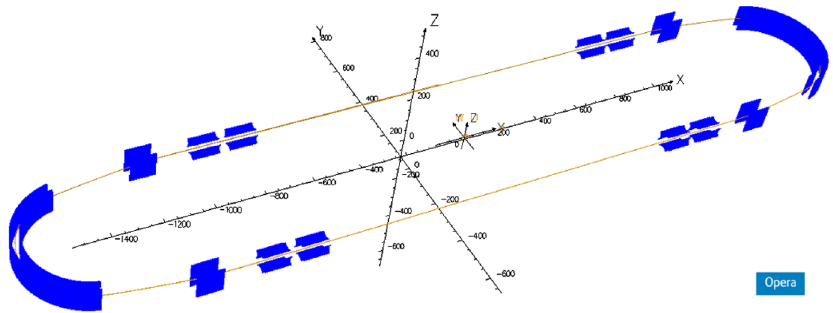
FIG. 1. Model of the ELISA ring in OPERA-3D . The dimensions and distances were taken from [4,13]. Particles were tracked over many turns in order to find a stable solution for the closed equilibrium